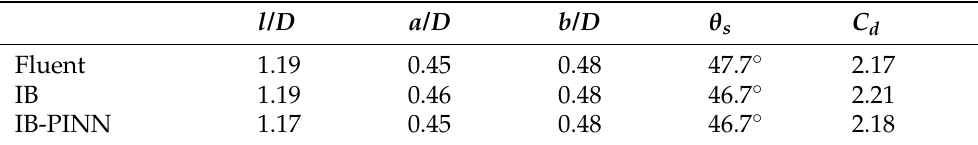
Table 1. The length and position of the separation bubble, the separation angle and the drag coefficient obtained using Ansys Fluent, mesh-based IB method and IB-PINN.